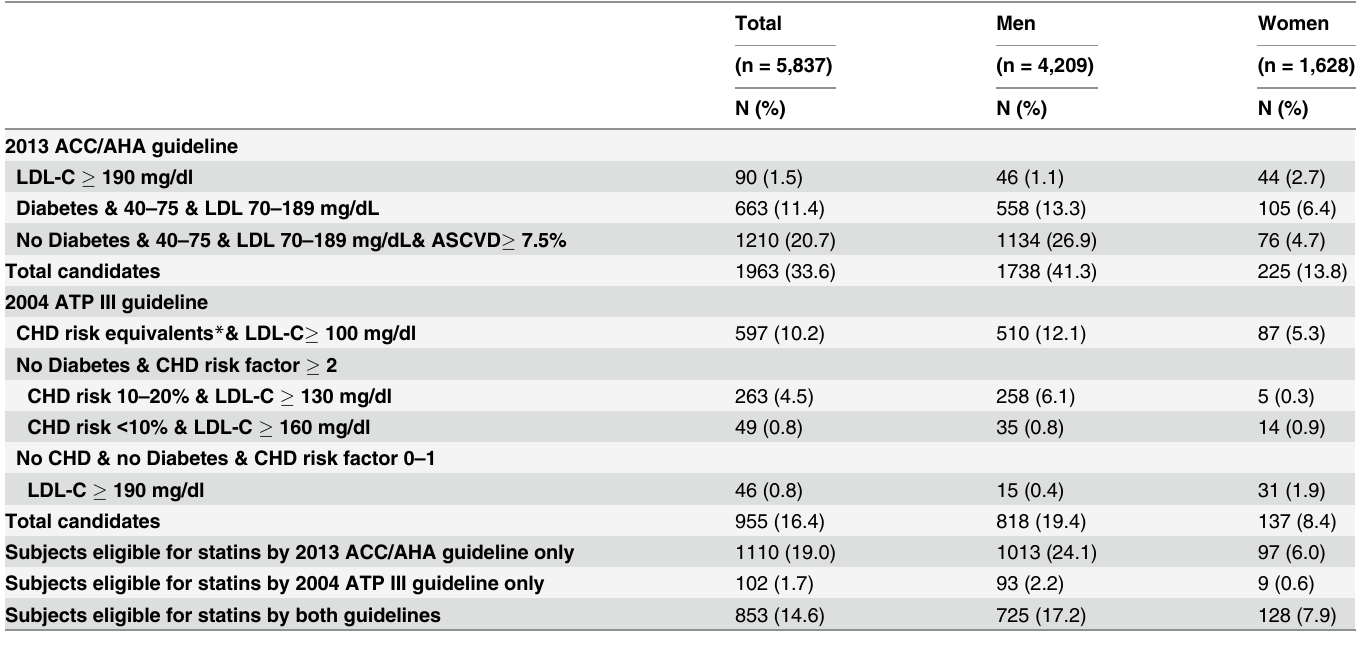
Table 2. Distribution of subjects who were candidates for lipid-lowering drug therapy for primary prevention (age 20 – 79